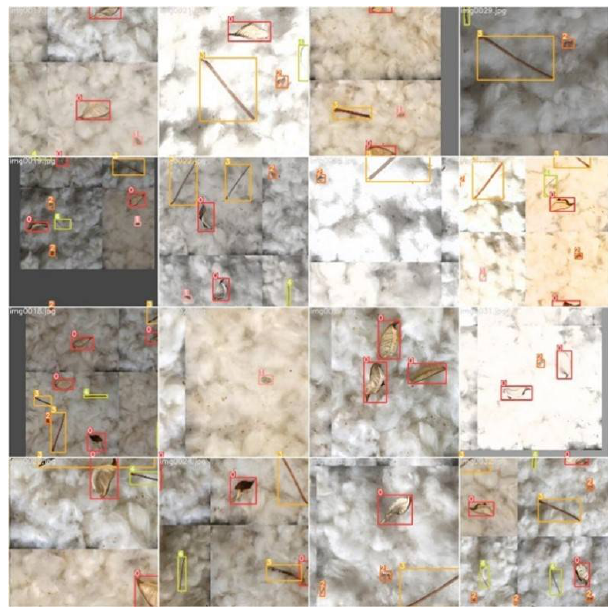
Figure 14. Training-process curves.